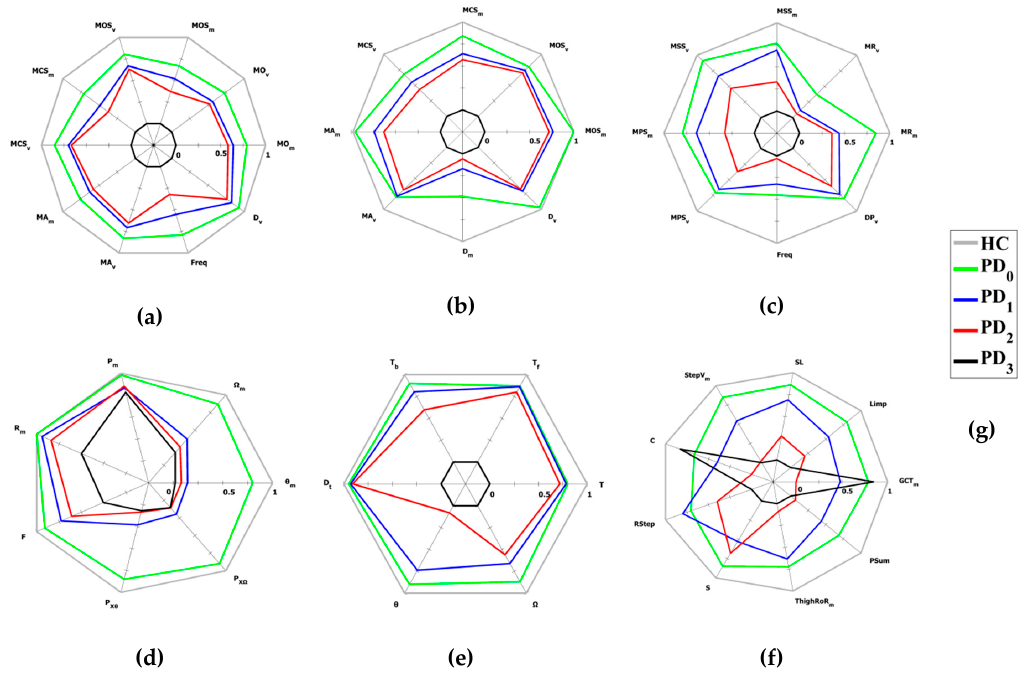
Figure 4. Radar charts of the kinematic parameters for upper and lower limb tasks. Mean values of the most significant kinematic parameters for healthy control (HC) and Parkinson’s disease (PD) subjects, grouped by severity classes according to the “video” scores assigned by N1, decrease monotonically with the increase of the impairment severity (Table S1 in Supplementary Materials for the parameter list and their meaning). ( a ) Finger tapping; ( b ) closing–opening; ( c ) pronation–supination; ( d ) leg agility; ( e ) sit to stand; ( f ) gait and ( g ) legend for HC and PD severity classes (HC refers to healthy controls; PD 0 refers to UPDRS 0 severity class; PD 1 refers to UPDRS 1 severity class; PD 2 refers to UPDRS 2 severity class; PD 3 refers to UPDRS 3 severity class).